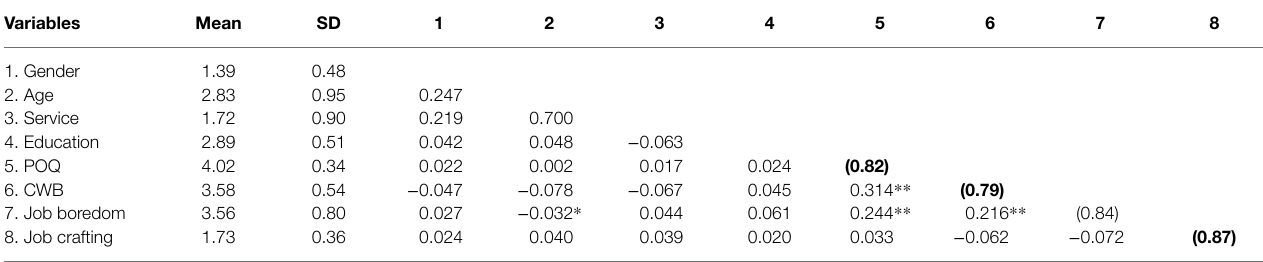
TABLE 1 | Correlations, mean, standard deviation, and reliability. Variables Mean